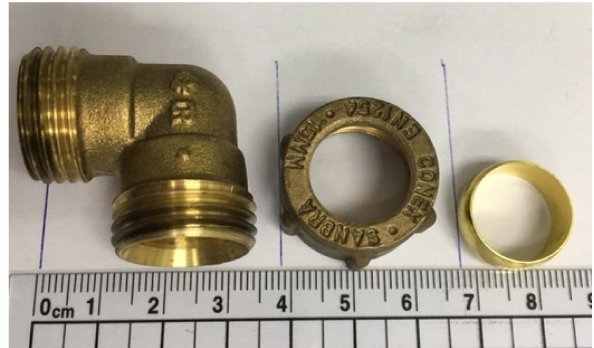
Figure 2. Photograph of brass fitting assembly: body ( left ); compression nut (middle) and compression ring ( right